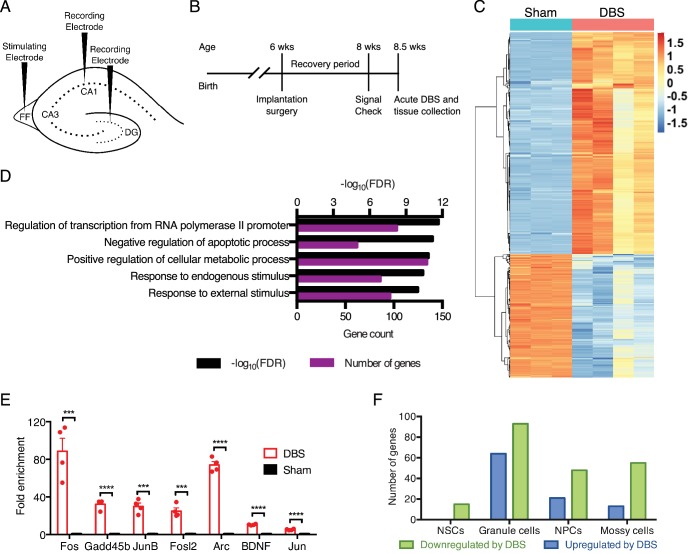
DBS alters the expression of many genes, including numerous transcriptional regulators in wild-type mice.(A) Schematic showing electrode placement for DBS. DG: dentate gyrus; FF: fimbria-fornix. (B) Timeline of implantation and tissue collection used for these studies. Signal check: single pulse induced evoked responses in the DBS pathway as recorded in the hippocampus were verified 1–2 days prior to acute DBS. (C) Heatmap showing protein-coding genes whose expression change at least 2-fold (with FDR < 0.05) following DBS in wild-type mice (WT). Sham columns are indicated by teal bar. DBS columns are indicated by the pink bar. (D) Gene ontology (GO) analysis of genes that are upregulated at least at least 2-fold (with FDR < 0.05) following DBS. (E) RT-qPCR validation of DBS upregulated genes in a new cohort of WT mice (n = 4 sham and 4 DBS mice; significance determined using an unpaired, two-tailed t-test; error bars: SEM; ***p<0.001; ****p<0.0001). (F) Numbers of genes found to be significantly altered in expression following DBS in different dentate gyrus cell types (p<0.01). NSCs: Neural stem cells; NPCs: Neural progenitor cells. Figure 1—figure supplement 1 shows preliminary RT-qPCR experiment data used to pick the optimal duration for acute stimulation, and it shows the overlap of DBS-upregulated genes with prior activity-dependent datasets. Figure 1—figure supplement 2 shows the stable RNA expression level of genes used as housekeeping genes in RT-qPCR experiments. Source data for all quantified gene expression data in WT sham and DBS samples is provided in Figure 1—source data 1. Figure 1—source data 2 provides the GO data used in Figure 1D. The complete PSEA results are available in Figure 1—source data 3.10.7554/eLife.34031.006Figure 1—source data 1.Quantified gene expression data from wild-type sham and DBS-treated mice.10.7554/eLife.34031.007Figure 1—source data 2.Gene ontology data for differentially expressed genes in wild-type samples following DBS.10.7554/eLife.34031.008Figure 1—source data 3.Detailed PSEA results showing cell type and DBS-treatment specific genes.The following information is provided in this table: coef.1 is the noise, coef.2 is the normalized population specific expression, coef.3 is the normalized relative differences between DBS and sham treatment, and pvalue.1, pvalue.2, and pvalue.3 indicate significance of coef.1, 2, or 3, respectively, as determined by the F-test in the linear regression analysis.